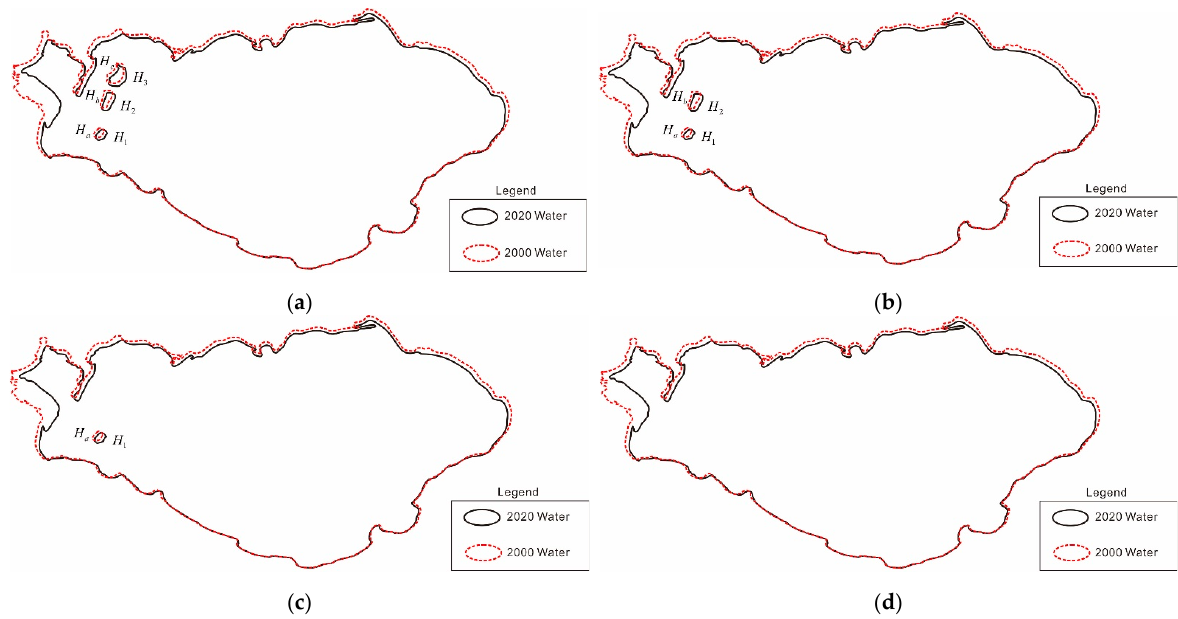
Figure 7. Four types of changes in the water body of Lake Gyaring from 2000 to 2020 in GLOBELAND30: ( a ) changes in the water body of Lake Gyaring with three sandbars; ( b ) changes in the water body of Lake Gyaring with two sandbars; ( c ) changes in the water body of Lake Gyaring with one sandbar; ( d ) changes in the water body of Lake Gyaring with no sandbars.